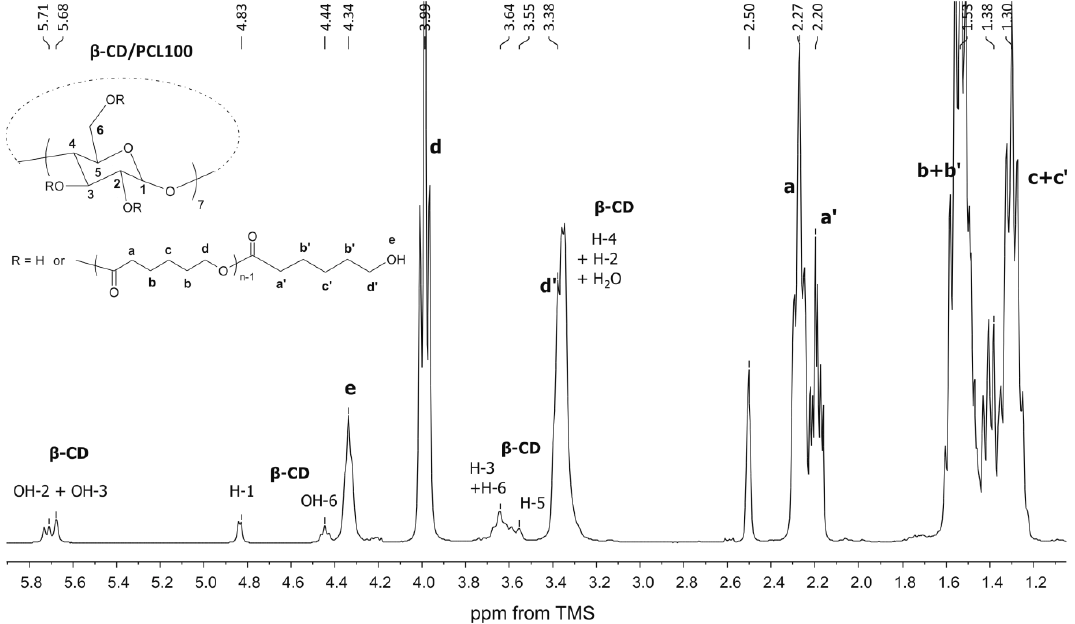
Figure 1. 1 H NMR spectrum of the β -cyclodextrin β -CD / PCL100 polymer. Table 1. The parameters of the ring-opening polymerization (ROP) of D,L- lactide (LA), L,L -lactide (LLA), and ε -caprolactone (CL) initiated by β -CD.